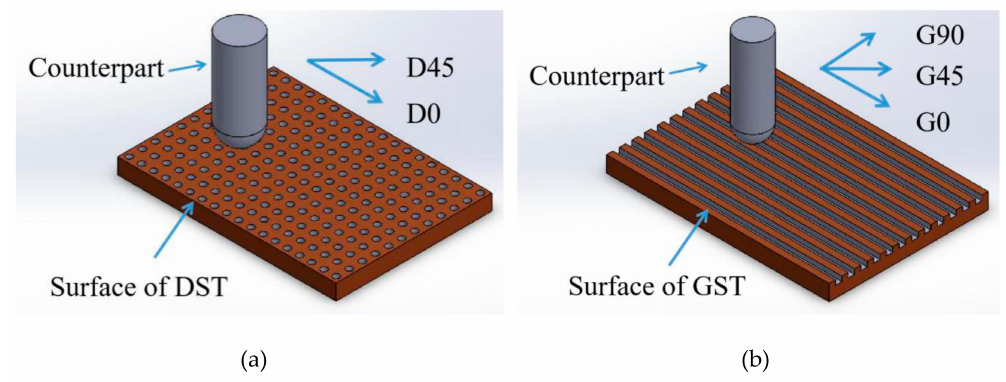
Figure 3. The principle diagram of the friction and wear experiments. ( a ) Friction direction on DST samples, parallel (D0)and 45 ◦ to dimple arrangement (D45), ( b ) friction direction on GST samples parallel(D0), 45 ◦ (D45) and vertical to the groove direction(D90).